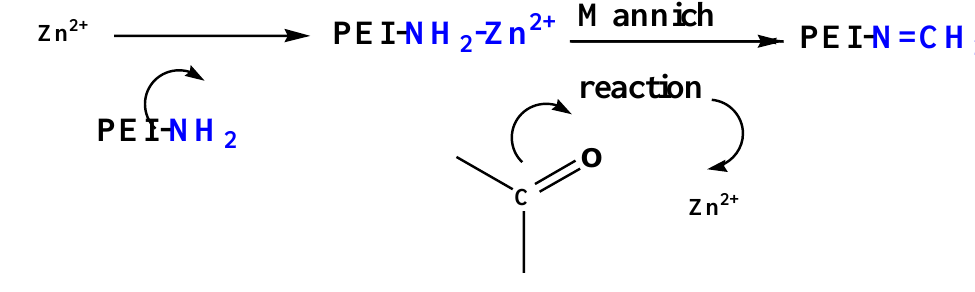
Table 5. Summary of the length, diameter, apparent density, and void fraction of ZnO NWs as a function of the concentration of zinc salt [Zn(NO 3 ) 2 ] ([Zn 2+ ]/[PEI] = 4.5; [Zn 2+ ]/[HMTA] = 1.33, grow- ing time of 6 h). For the HMTA and PEI concentration values for different [Zn(NO 3 ) 2 ] concentrations, see Table